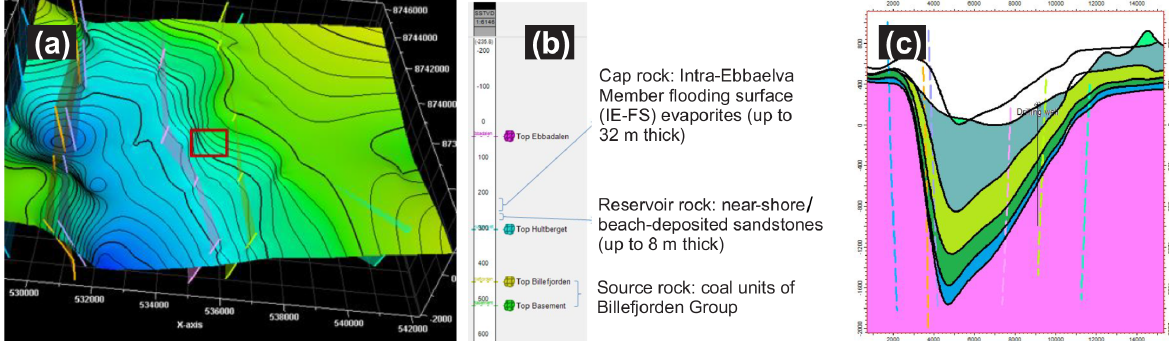
Figure 8. Examples from the Billefjorden license claim assignment, conducted by the 2019 AG222 class. (a) Top reservoir structure contour map with fault zones and the area to be fictionally claimed (red rectangle). (b) Well prognosis, illustrating key petroleum system elements like source and reservoir rocks. (c) East–west cross section across the proposed drill